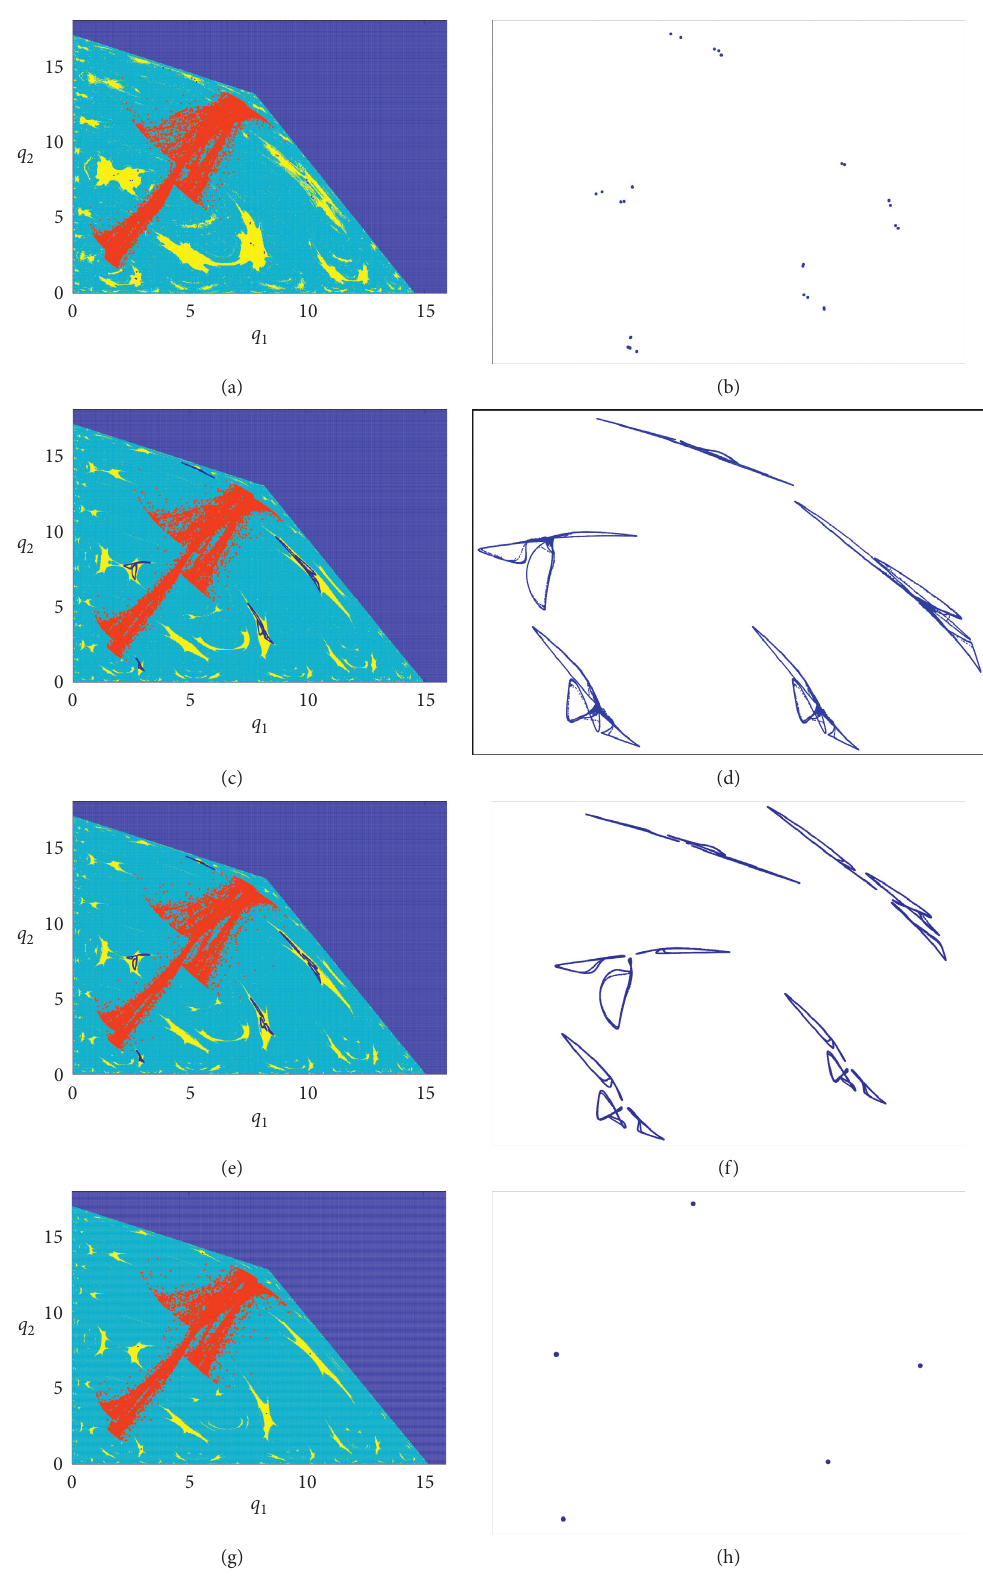
Figure 5: Basins of attraction and partial enlargement of the attractor with different values of parameter α , where the rest of parameters are � 6, a − c � 7 . 6, b � 0 . 3, β � 0 . 25, v � 0 . 44, and v � 0 . 38, and the coexistence of multiple attractors can be found. Basin of fixed as a − c 1 2 1 2 attraction with (a) α � 0 . 087, (c) α � 0 . 128, (e) α � 0 . 135, and (g) α � 0 . 15. (b) Sketch of enlargement of the blue attractor in (b) Figure